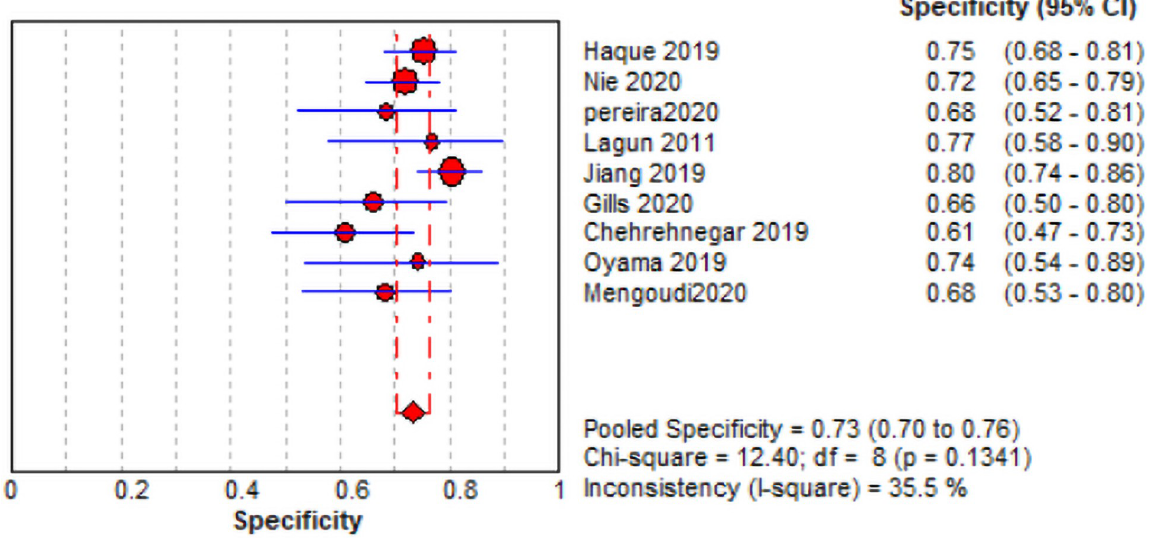
Fig 5. Specific (red diamond) forest map and 95% CI (blue horizontal